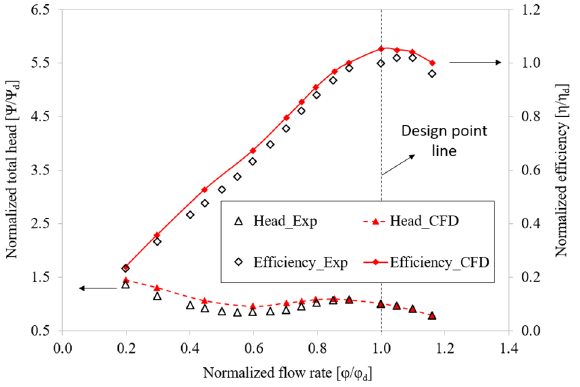
Figure 8. Hydraulic performance of the numerical and experimental